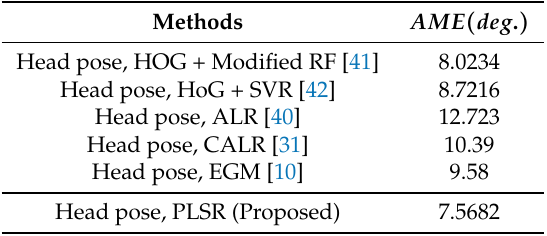
Table 4. The Mean Absolute Error of gaze estimation using head pose and gaze